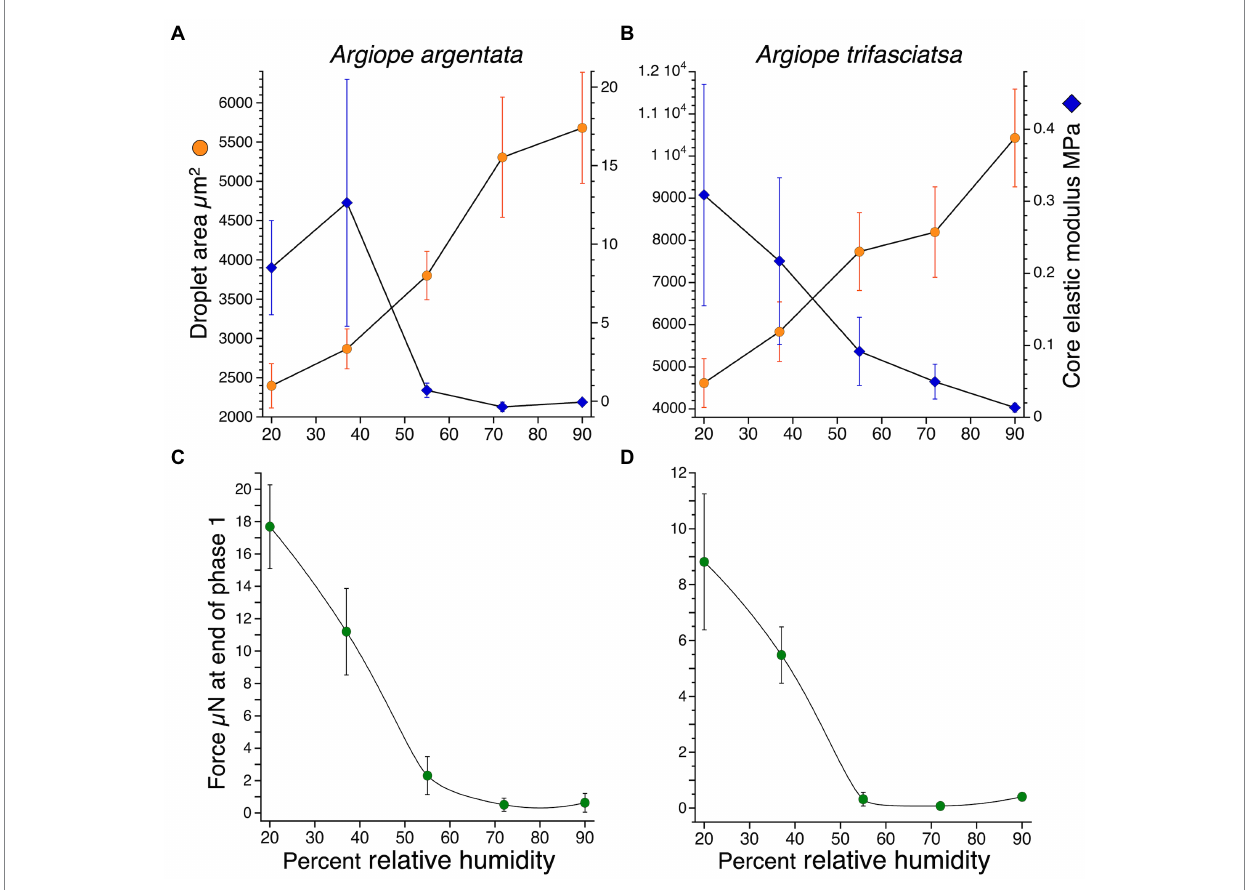
FIGURE 4 Paired plots of Argiope argentata and A. trifasciata flattened droplet areas and protein core elastic modulus at five humidities (A,B) and the associated forces on droplets at the end of phase one extension (C,D) . Values are mean ± standard